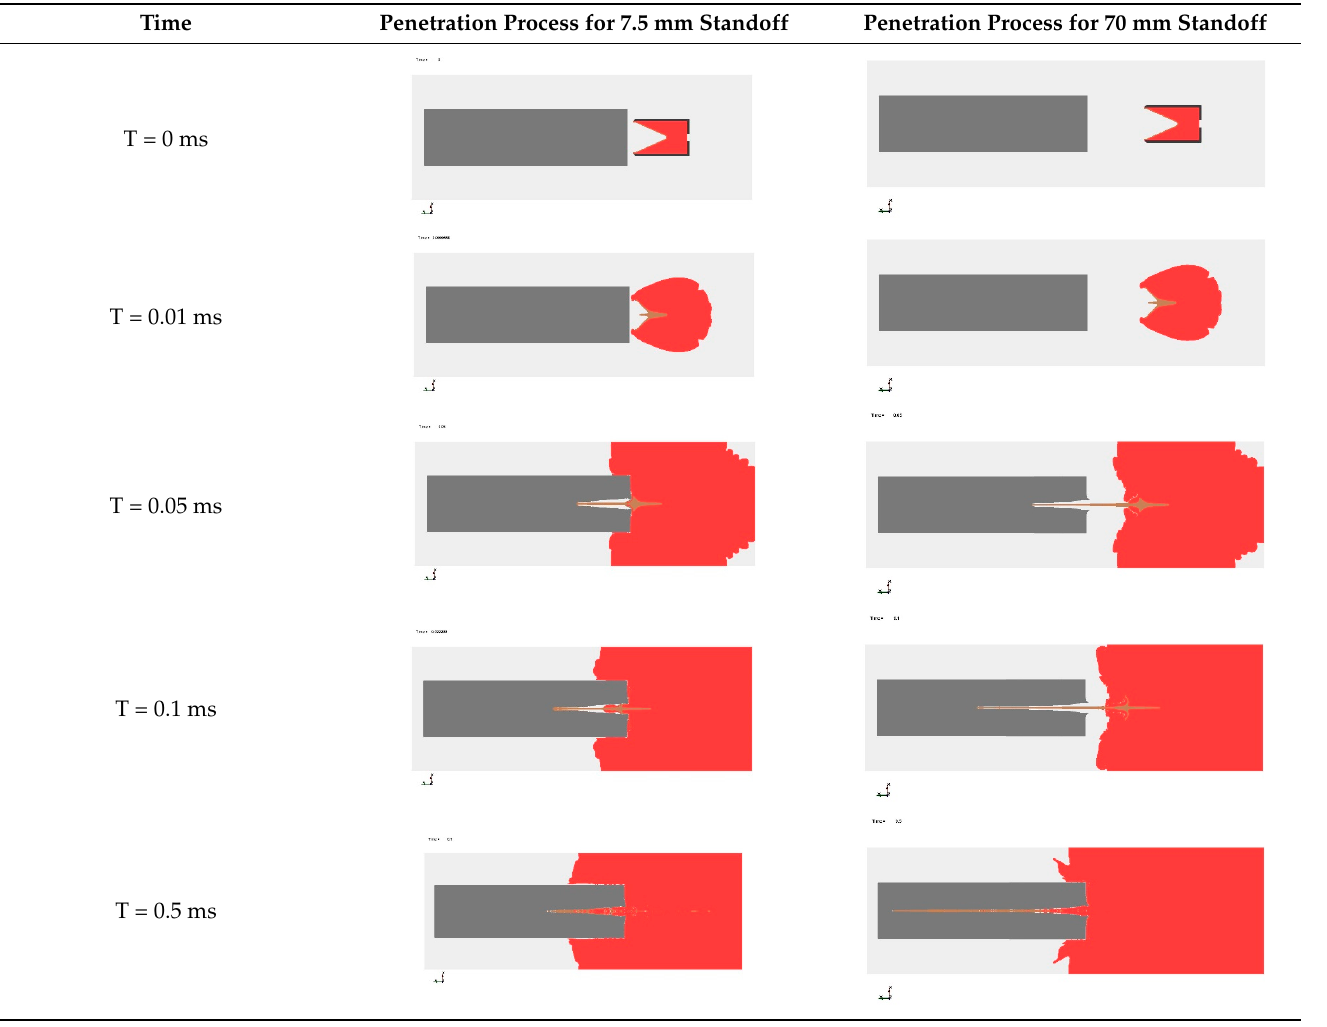
Table 5. View of the propagation process of detonation products and the penetration process of the shaped charge inside the steel target.